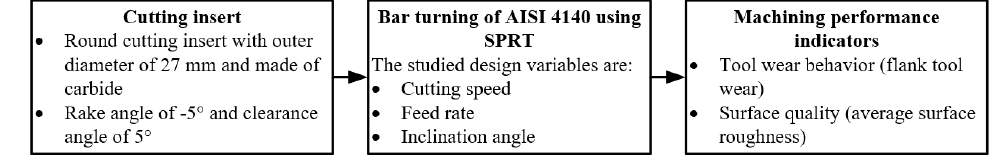
Figure 3. Flow chart of the experimental procedures.